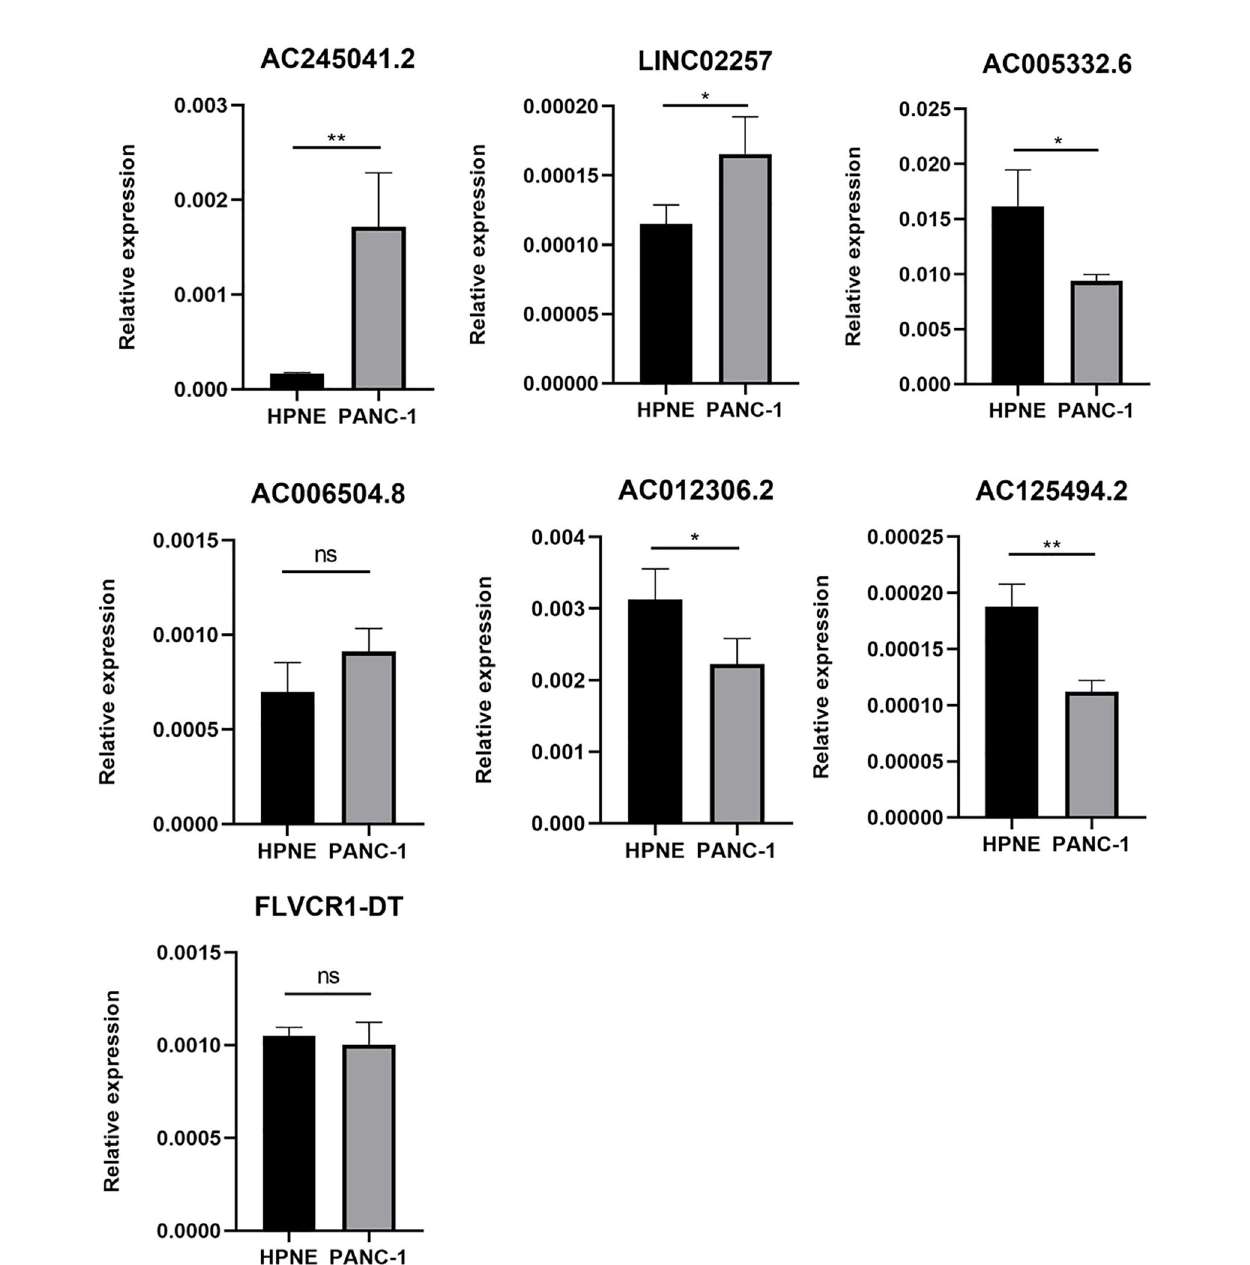
FIGURE 6 | Expression of 7 lncRNAs in HPNE and PANC-1 cells. The qRT-PCR result showed that AC245041.2 and LINC02257 were high-expressed in PANC-1. AC005332.6, AC012306.2, AC125494.2 were low-expressed in PANC-1. The expression of FLVCR1-DT and AC006504.8 was not statistically different between PANC-1 and HPNE. *P < 0.05, **P < 0.01, NS, no statistically signi fi